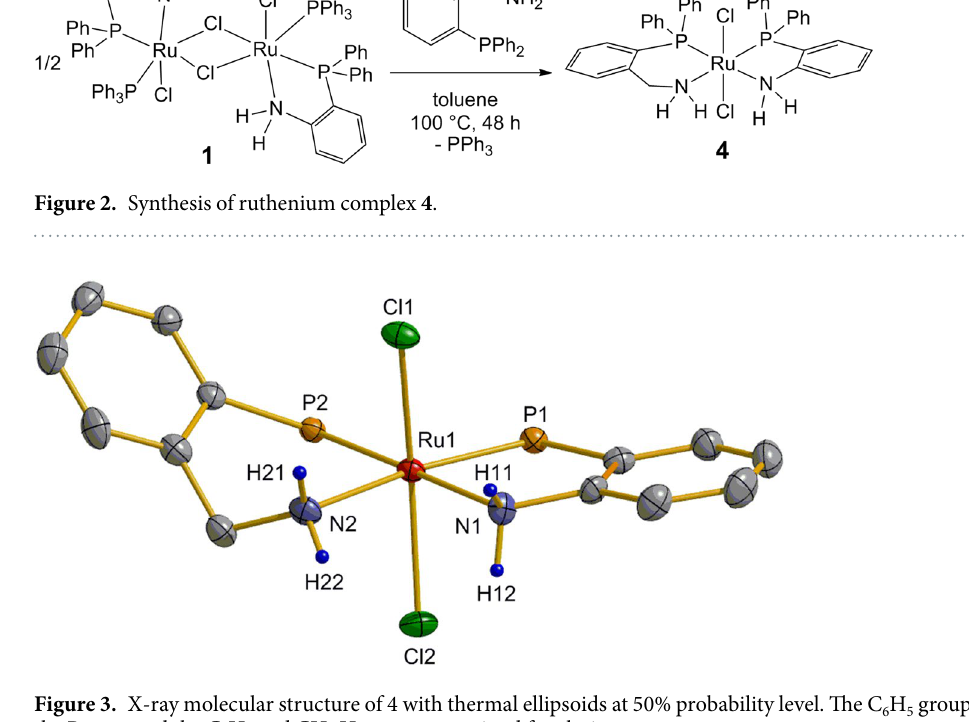
Figure 3. X-ray molecular structure of 4 with thermal ellipsoids at 50% probability level. The C 6 H 5 groups at the P atom and the C 6 H 4 and CH 2 H atoms are omitted for